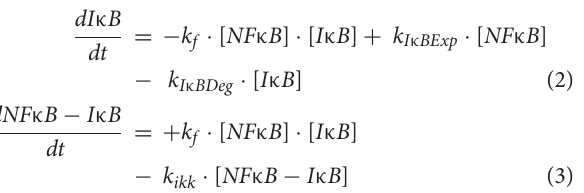
of signaling crosstalk in cell populations. NF κ B activity